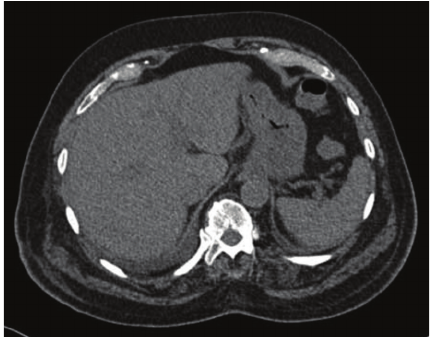
Figure 4: CT showing resolution of the hepatic portal venous gas (Case